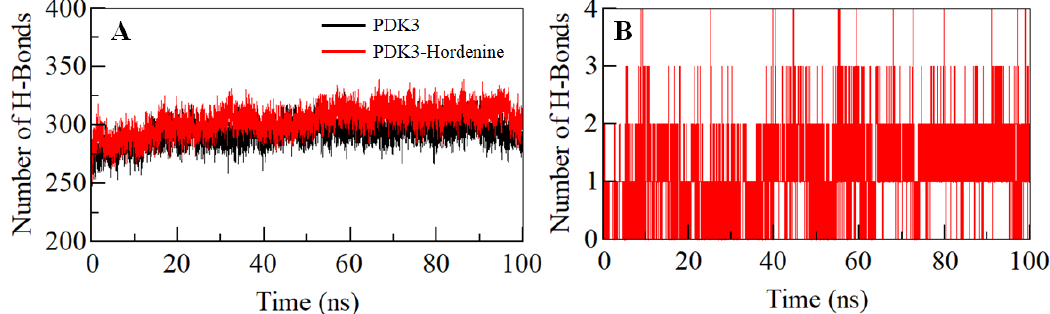
Figure 3. Time evolution and stability of hydrogen bonds. ( A ) Intramolecular within PDK3, and ( B ) intermolecular between Hordenine and PDK3.